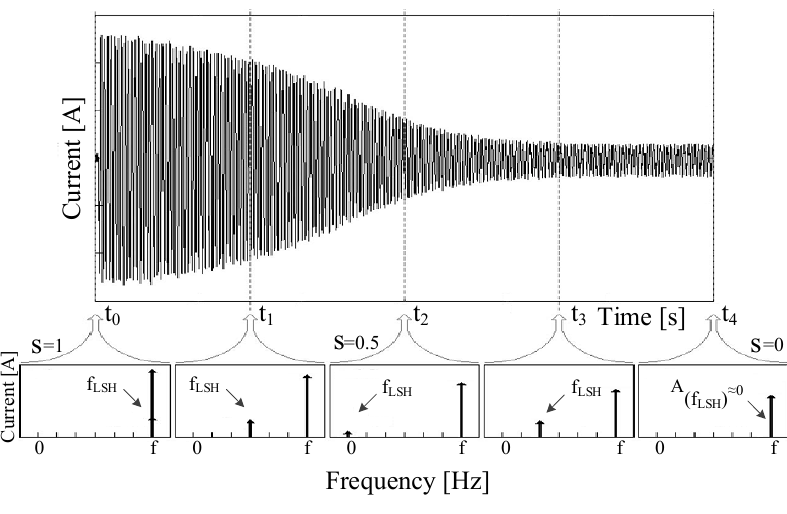
Figure 3. Behavior (cid:1858) (cid:3013)(cid:3020)(cid:3009) during the start-up for LS-PMSM. Figure 3. Behavior f LSH during the start-up for